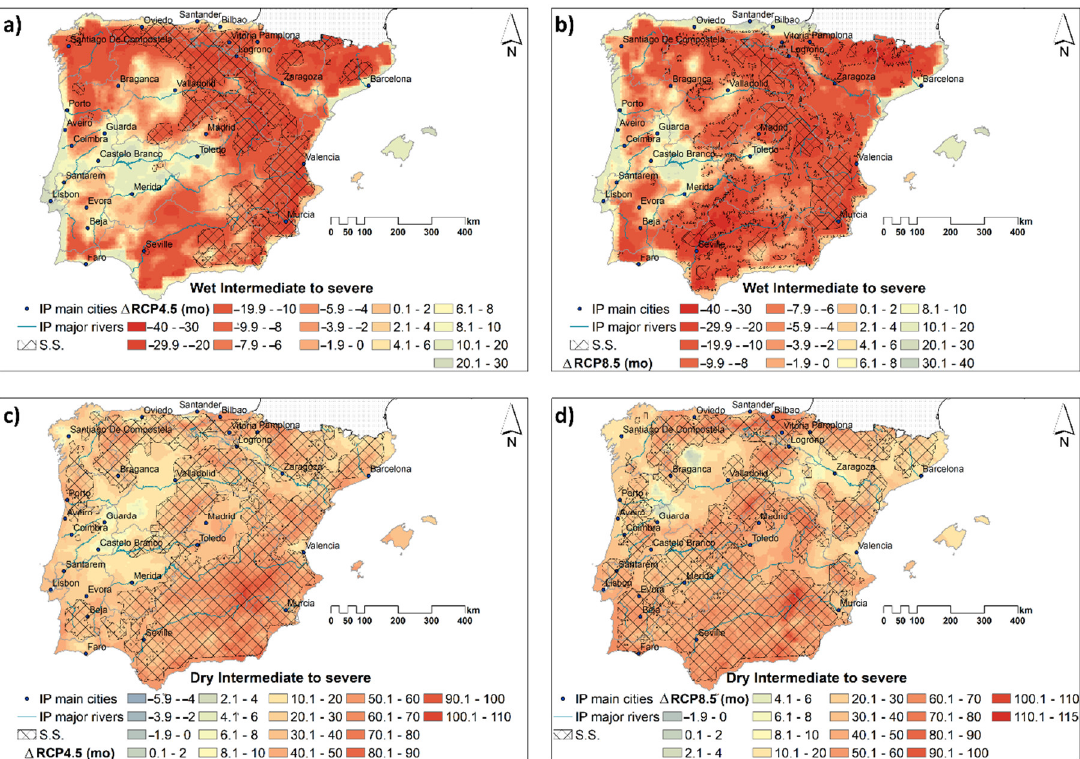
Figure 6. Statistically significant differences (MWW at a 5% significance level) between 2041–2070 and 1961 − 1990 for the duration, in months (mo) of 12m-WASP intermediate-to-severe wet events in IP under ( a ) RCP4.5 and ( b ) RCP8.5; and for the intermediate-to-severe dry events under ( c ) RCP4.5 and ( d ) RCP8.5. (Note: NUTS 2 in grey contours; and ∆(2041–2070–1961–1990)).